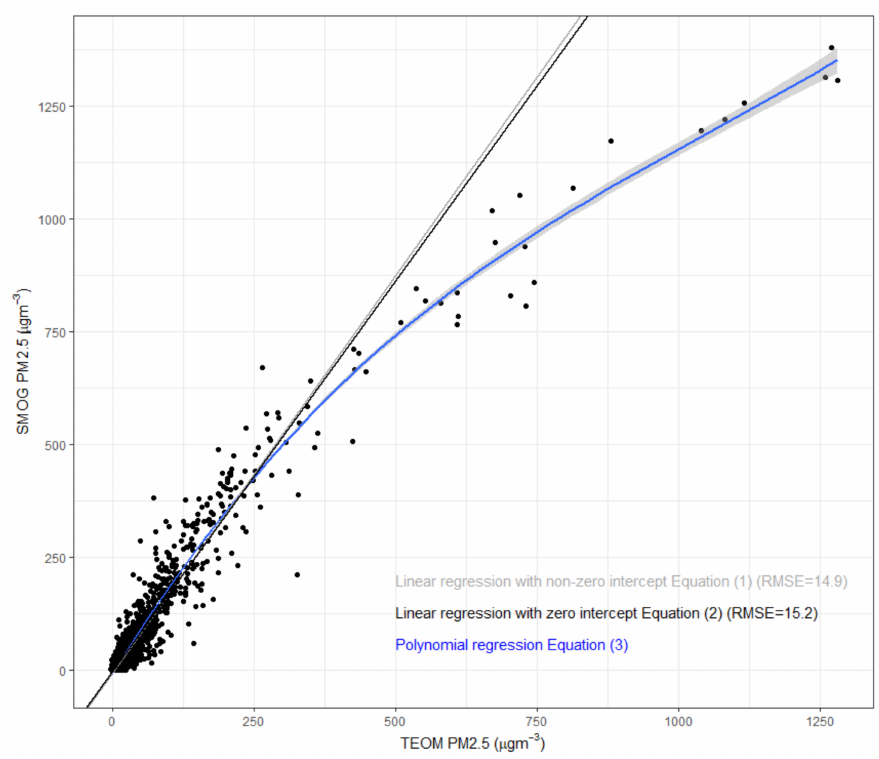
Figure 2. Fitted calibration curves for the SMOG units against the TEOM. A linear multivariate regression with additive terms for temperature and relative humidity was also developed for the SMOG PM 2.5 concentrations in the 0–600 µ g m − 3